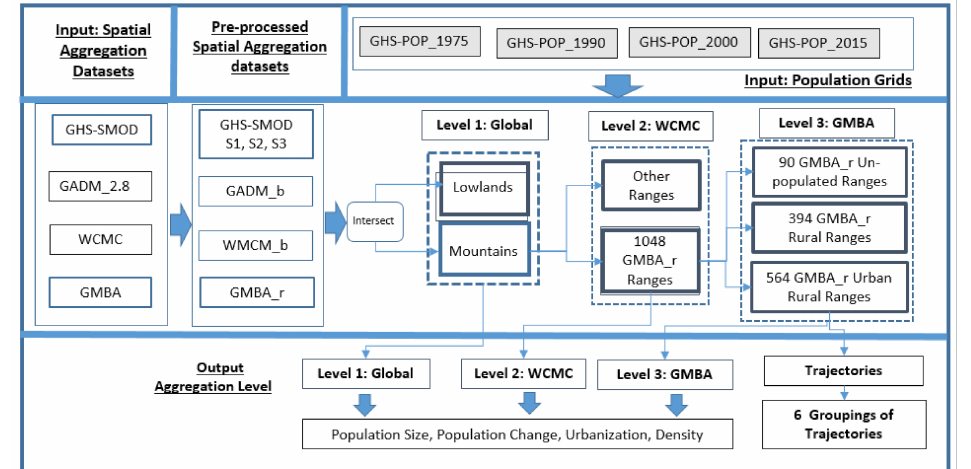
Figure 1. The workflow shows the input Spatial Aggregation Datasets and Population and the output Spatial Aggregation levels. Level 1: Global terrestrial land masses partitions Mountains and Lowlands. Level 2: WCMC partitions GMBA from Other ranges; Level 3: GMBA groups ranges based on population presence, urbanisation rates, population change, and density and then re-groups them into trajectories—ranges with similar